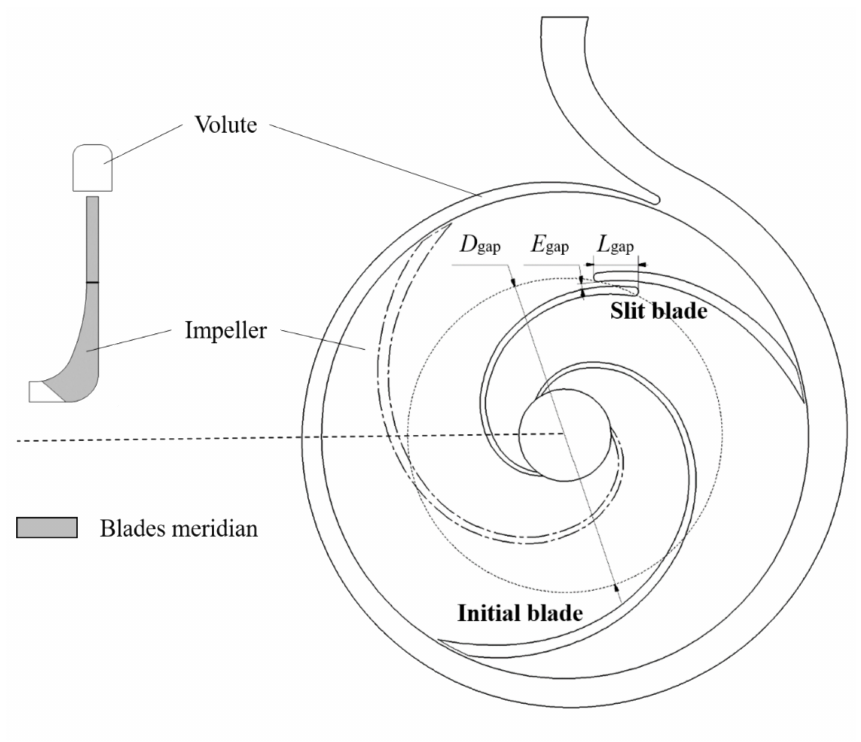
Figure 1. Two-dimensional hydraulic assembly